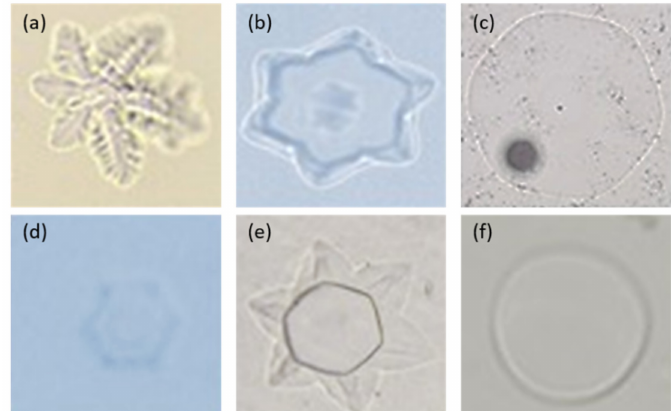
Figure 2. The formation of ice crystals exhibited by recombinant GaAFPs. Ice crystals in samples containing a mixture of recombinant GaAFP: ( a ) all recombinant GaAFPs; ( b ) GaAFPs with high TH activity (more than 0.05 ◦ C); ( c ) GaAFPs with low TH activity (less than 0.05 ◦ C); ( d ) GaAFPs with moderate TH activity (0.05 ◦ C); ( e ) GaAFPs with high and low TH activity; ( f ) control treatment containing proteinase